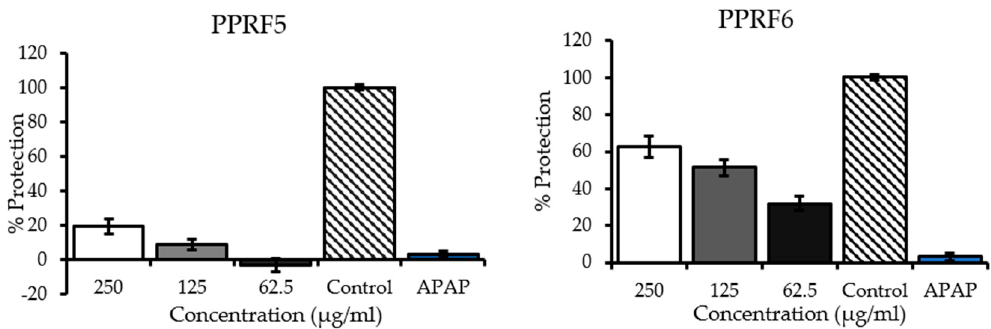
Figure 3. Effect of polyphenolic-rich fractions of L. tetragona on acetaminophen (100 mM)-induced cytotoxicity in HepG2 cells. The values are expressed as the mean ± SD percentage of control ( p < 0.05) from three replicates of independent experiments. APAP: Acetaminophen.